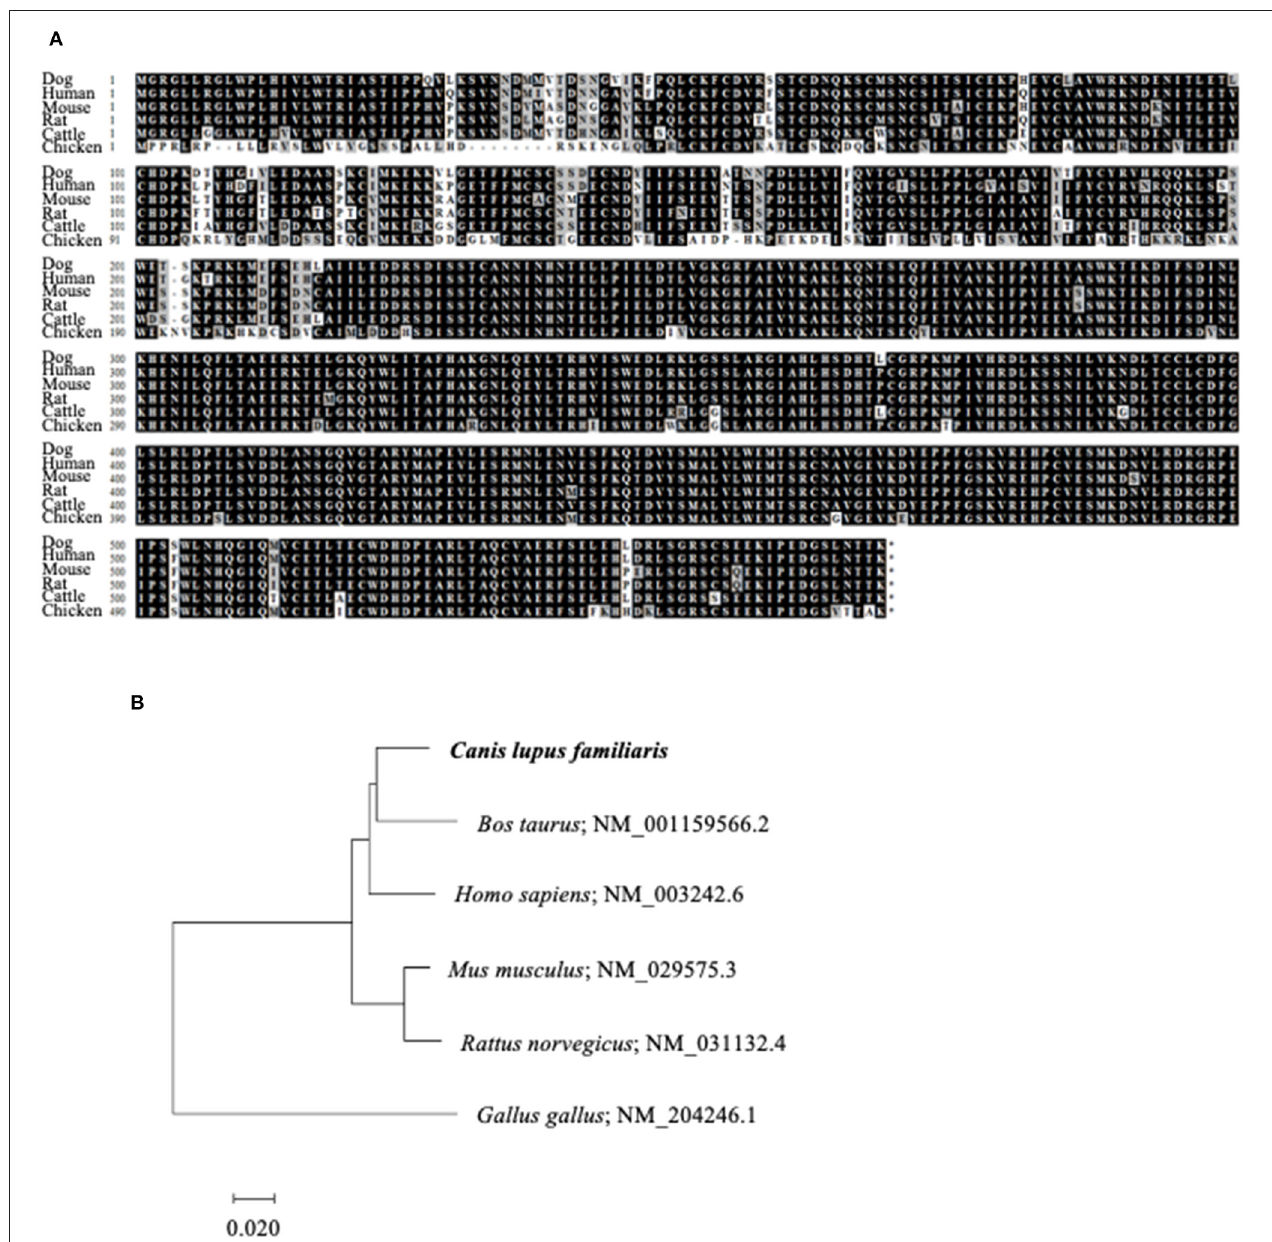
FIGURE 3 | Identification of canine TGFBR2 gene. (A) Multiple alignment of TGF- β RII. The deduced amino acid sequence of canine TGFBR2 gene was aligned with those of other species. (B) The phylogenetic tree of canine TGF- β RII in relation to those of other species. GenBank accession numbers were listed beside the scientific names. The scale bar indicates the branch